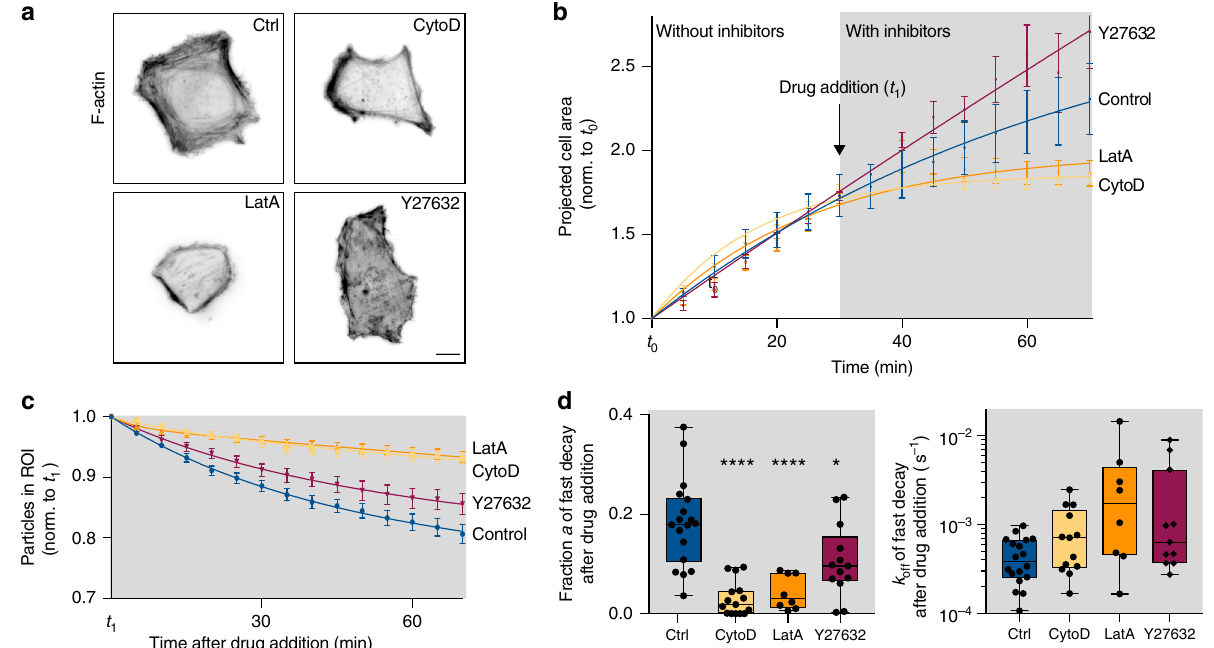
Fig. 5 Actin/myosin inhibition signi fi cantly reduces tearing off surface-bound particles. a Inverted wide- fi eld fl uorescence images of HeLa cells fi xed 90 min post drug addition. Actin fi laments were immunolabeled with phalloidin-TRITC. Scale bar = 10 µ m. b Projected cell area normalized to t 0 of cells spreading on the matrix-mimetic surfaces decorated with nonspeci fi c AuNPs (#1, see Fig. 4) over time. Actomyosin disrupting drugs Cytochalasin D (CytoD, 60 nM), Latrunculin A (LatA, 100 nM) or ROCK inhibitor (Y27632, 20 µ M) were added 1 h after seeding of the cells. c Relative number of particles in the ROI under the cells over time after drug treatment. ( n = 19, 15, 14, 15 cells, 2 technical repeats, data are represented as mean ± s.e.m. and fi tted with an exponential decay function) d For the particles being actively removed by the HeLa cells, the fraction a and the off rate k off are shown as obtained by fi tting from the two-phase-decay of particles in the ROI. (Box-plots represent median ± 95% CI with whiskers to the min and max values, * P = 0.0145, **** P < 0.0001; one-way ANOVA with post hoc Tukey). Source data are provided as a source data fi